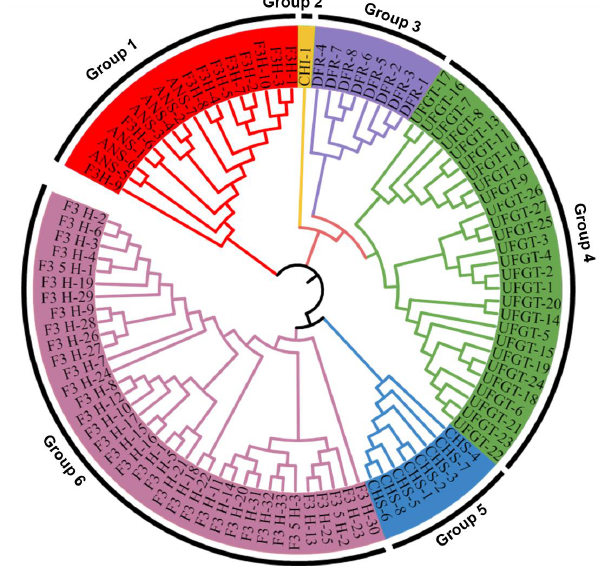
Figure 7. Phylogenetic tree showing the clustering of various target genes. Different colors depict the different gene groupings based on protein similarity. Blue represents CHS genes; purple represents DFR genes; pink represents the F 3′ H and F 3′5′ H genes; yellow represents the CHI gene; red represents the combined F3H and ANS genes; and green represents UFGT genes. We further tried understanding the syntenic link between wheat and its genome con- tributors because wheat evolved through hybridization. Chromosome-wise classification of orthologous anthocyanin biosynthetic genes in Triticum urartu , Aegilopus tauchi, and T. dicoccoides was depicted by the circular ideogram of Circos (Figure 8). The anthocyanin biosynthesis genes of Ae . tauschii (D-donor), T . urartu (A-donor) and T . dicoccoides (a tetra- ploid, AB genome) showed high levels of conservation as predicted. On T . urartu (A ho- moeologs) and Ae . tauschii (D homoeologs), it was shown that up to 60 – 80% of the antho- cyanin biosynthetic genes of each chromosome were syntenic with their corresponding chromosomes; however, this percentage was higher in T . dicoccoides (Figure 8).